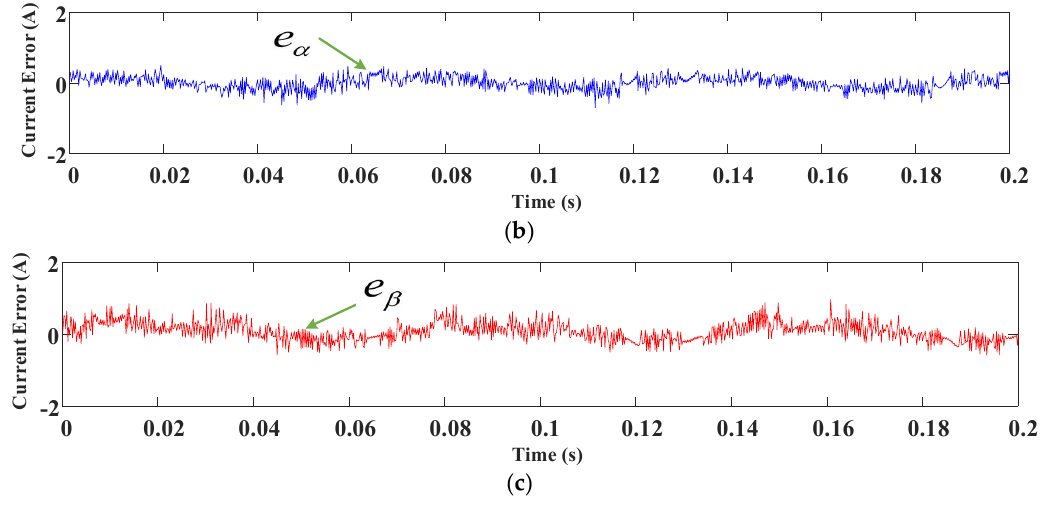
Figure 14. Experimental results of SVV-MFPCC following a sinusoidal current command with amplitude 3 A and frequency 30 Hz (case 2): ( a ) current responses; ( b ) α -axis current error; ( c ) β -axis current error.